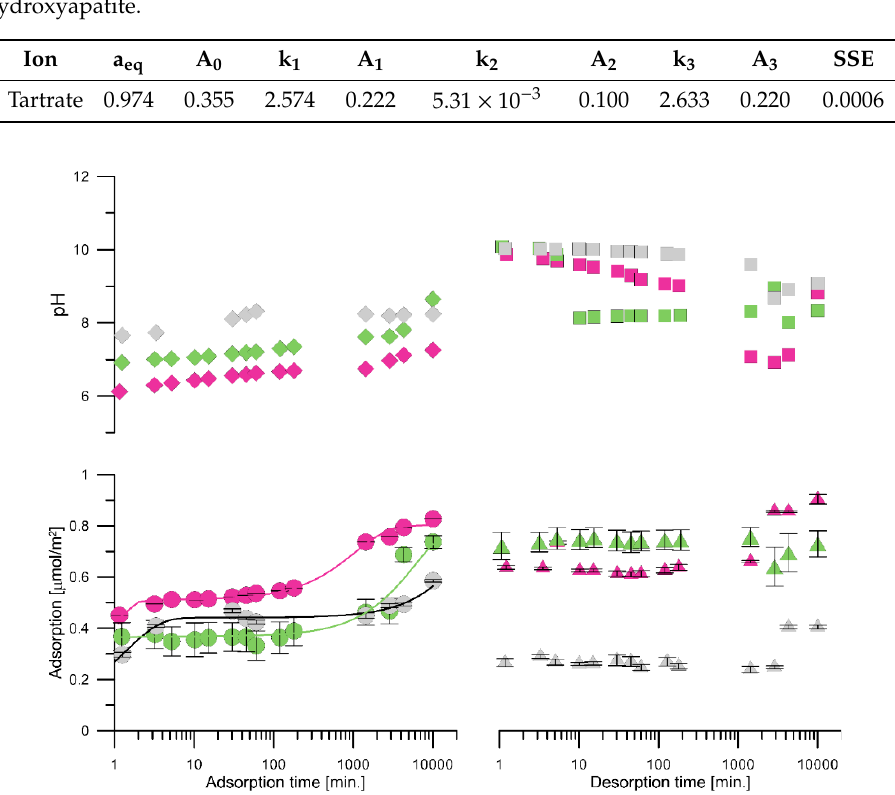
Figure 2. Kinetics of pH changes of the suspension and carboxylic ion adsorption changes on hydroxyapatite from the carboxylic ion solution of the initial concentration 0.001 mol/dm 3 . The experimental data points: grey—oxalic ions, green—citric ions and wine color—tartaric ions. The black, green and wine colored lines represent multiexponential equation fitting the data of adsorption kinetics of oxalate, citrate and tartrate ions. The parameters of adsorption fitting line are presented in Table 3. Table 3. Parameters of the multiexponential equation fitted to the data of adsorption kinetics of oxalate, citrate and tartrate ions from the solutions of the initial concentration 0.001 mol / dm 3 on the hydroxyapatite.